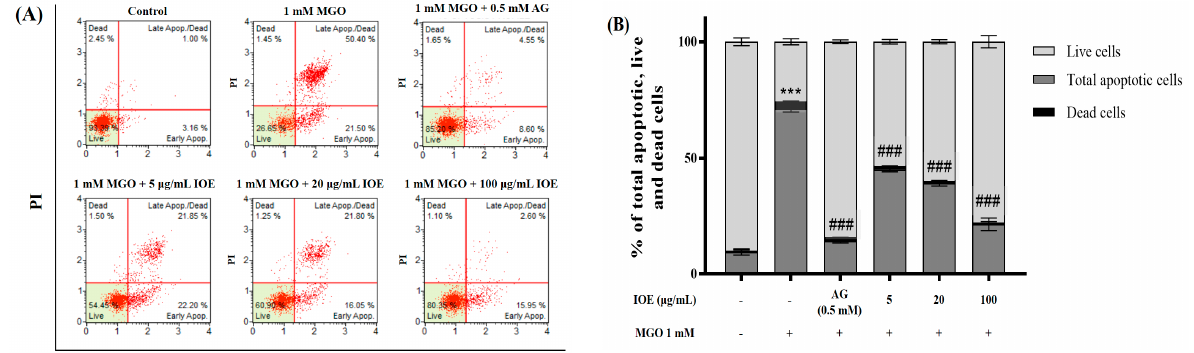
Figure 4. Protective effects of IOE on MGO − induced apoptotic cell death. Preventive effect of IOE on MGO-induced apoptosis in mouse glomerular mesangial cells. Dot plots for flow cytometric analysis of apoptotic cells. Annexin V − positive cells were assigned to the upper − right (late stage apoptotic cells) and lower − right (early stage apoptotic cells) quadrants, respectively. Dead cells are presented in the upper − left in the dot plots. Living cells without signs of apoptosis in the lower − left quadrant were negative for both Annexin V & PI staining ( A ). Bar graph showing the percentage of live, apoptotic (early and late apoptotic), and dead cells determined using the Muse™ Annexin V & Dead Cell Kit ( B ). Each experiment was performed three times independently. Bar values are presented as mean ± standard deviation ( n = 3) (*** p < 0.001 vs. normal group and ### p < 0.001 vs. MGO − treated